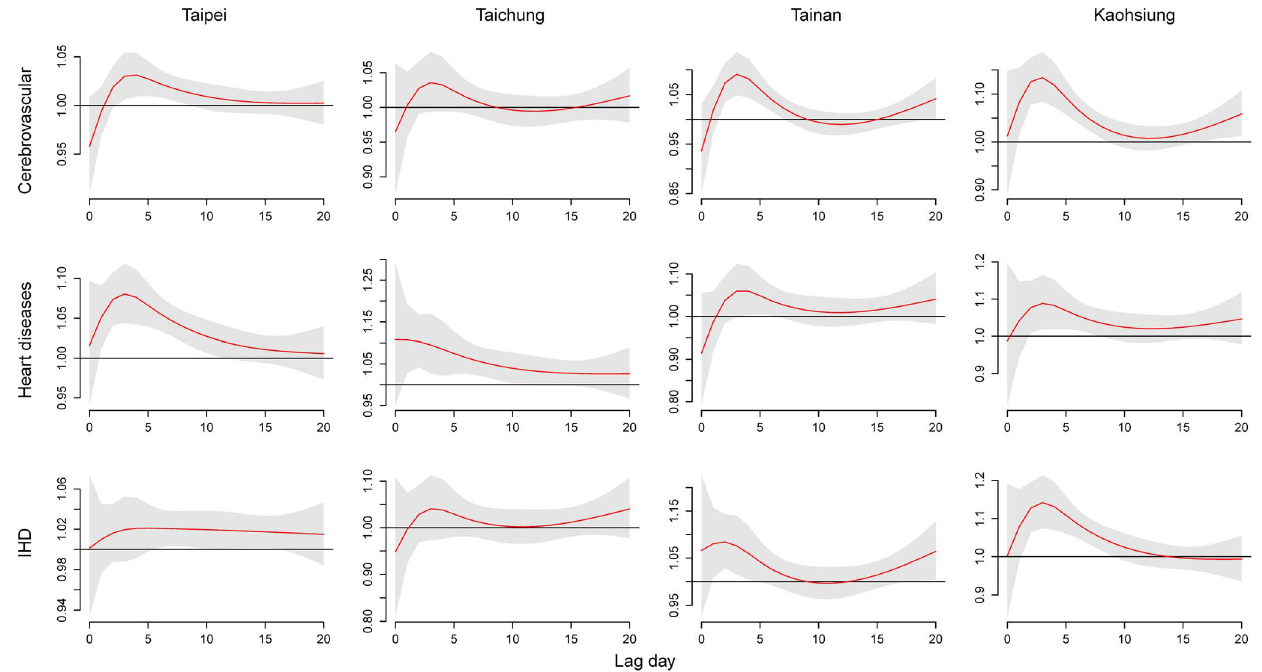
Figure 5. Mortality risks for cerebrovascular diseases, heart diseases, and IHD associated with an ambient temperature of 15 6 C compared to a centered temperature of 27 6 C on lag 0 to 20 in metropolitans Taipei, Taichung, Tainan, and Kaohsiung during 1994–2007.